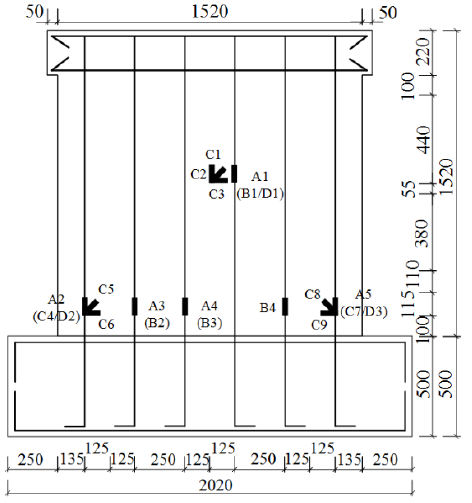
Figure 4. Strain gauge arrangement.